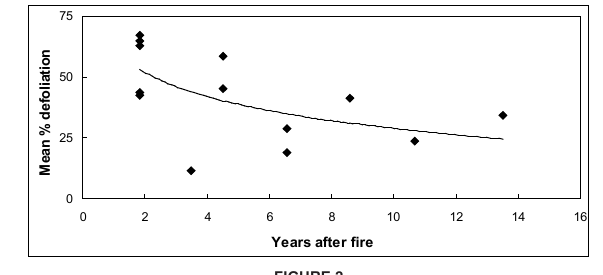
FIGURE 2 Mean percentage defoliation of Themeda triandra in relation to years after fire (2005 data)